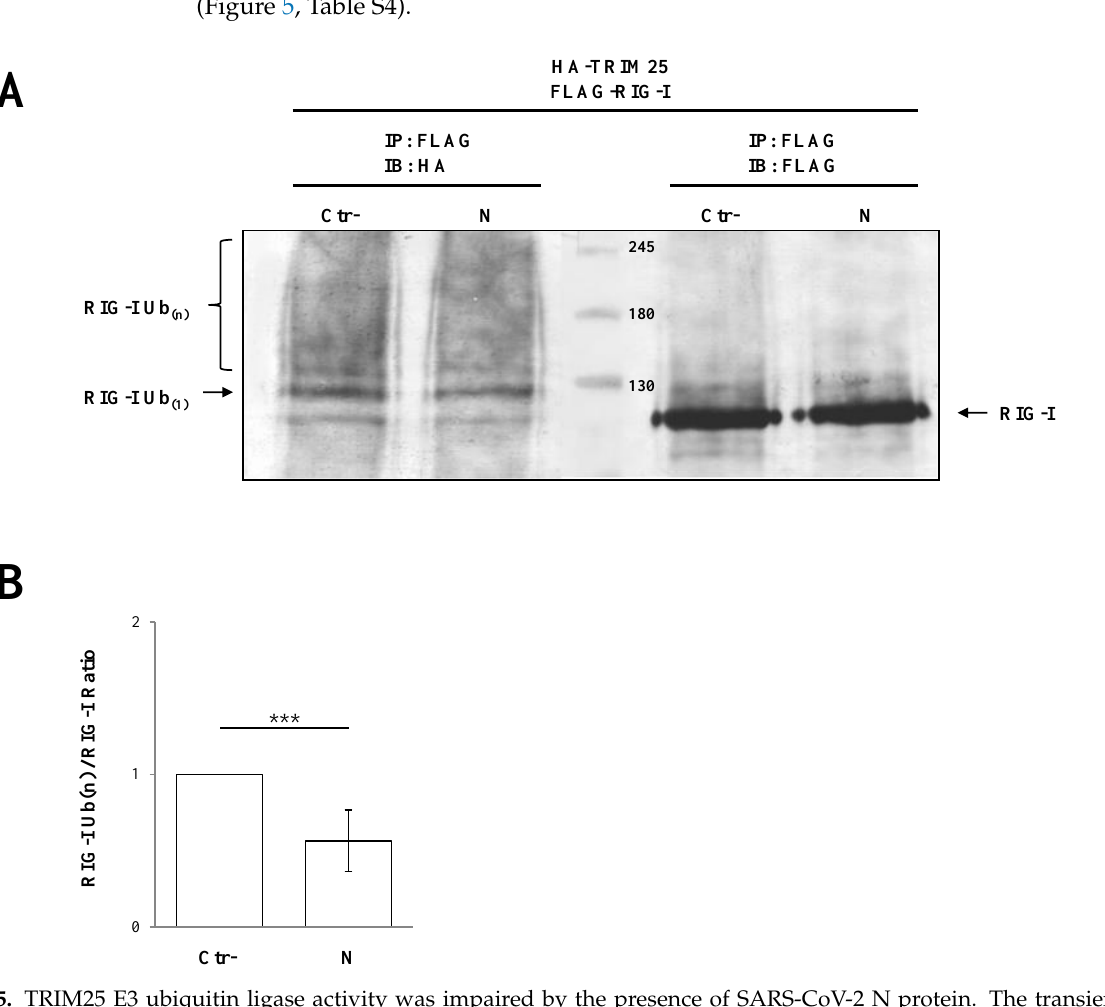
Figure 5. TRIM25 E3 ubiquitin ligase activity was impaired by the presence of SARS-CoV-2 N protein. The transient expression of SARS-CoV-2 N protein affected the ability of TRIM25 to mediate RIG-I ubiquitination in Lenti-X 293T cells. ( A ) Cells transfected with plasmids expressing FLAG-RIG-I, HA-TRIM25, HA-K63-only ubiquitin mutant and, where indicated, the SARS-CoV-2 N protein, were treated with the proteasome inhibitor MG-132 for 12 h. Lysates, prepared under denaturing conditions as described in the Material and Methods section, were immunoprecipitated with anti-FLAG magnetic beads, and precipitated proteins were resolved by SDS-PAGE. Pulled proteins were detected by immunoblotting with anti-HA or anti-FLAG monoclonal antibodies. Blots are representative of at least two biologically independent experiments. ( B ) The RIG-I ubiquitination rate was determined by densitometric analysis calculating the ratio between mono- and poly-ubiquitinated RIG-I (anti-HA) and relative RIG-I levels (anti-FLAG). Fold changes in RIG-I ubiquitination were calculated for N-containing samples relatively to the control sample. Results are expressed as mean ( n = 3) fold change ± standard deviation (SD), and significance was determined by p -value (*** p <